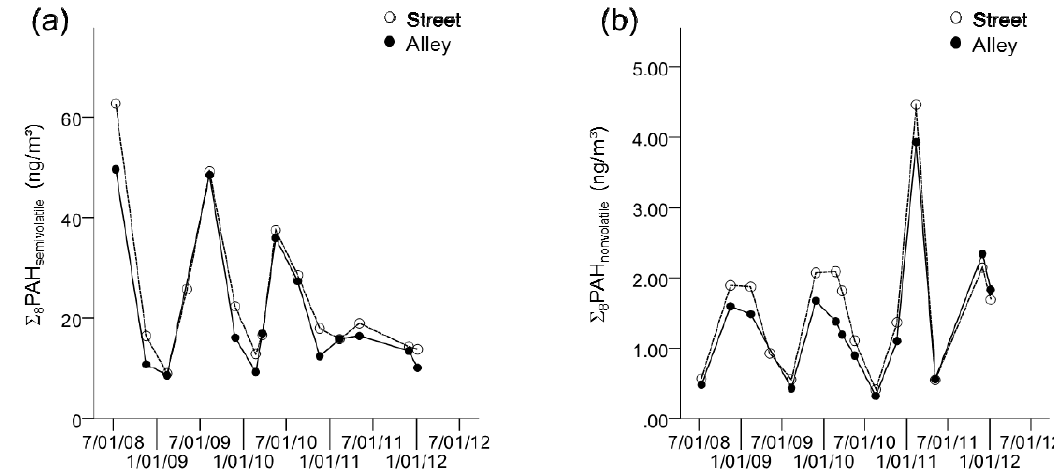
Figure 2. Central site comparison of ( a ) Σ 8 PAH semivolatile and ( b ) Σ 8 PAH nonvolatile concentrations: street vs. alley. Notes: Each dot represents one measurement collected over two weeks. ( a ) the sum of eight semivolatile PAHs ( Σ 8 PAH semivolatile : Phe, 1Meph, 2Meph, 3Meph, 9Meph, 1,7DMeph, 3,6DMeph, and Pyrene); ( b ) the sum of eight nonvolatile PAHs ( Σ 8 PAH nonvolatile : BaA, Chry, BbFA, BkFA, BaP, IP, DahA, and BghiP). The white circle represents measurements from the street side monitor and the black circle from the alley side monitor.